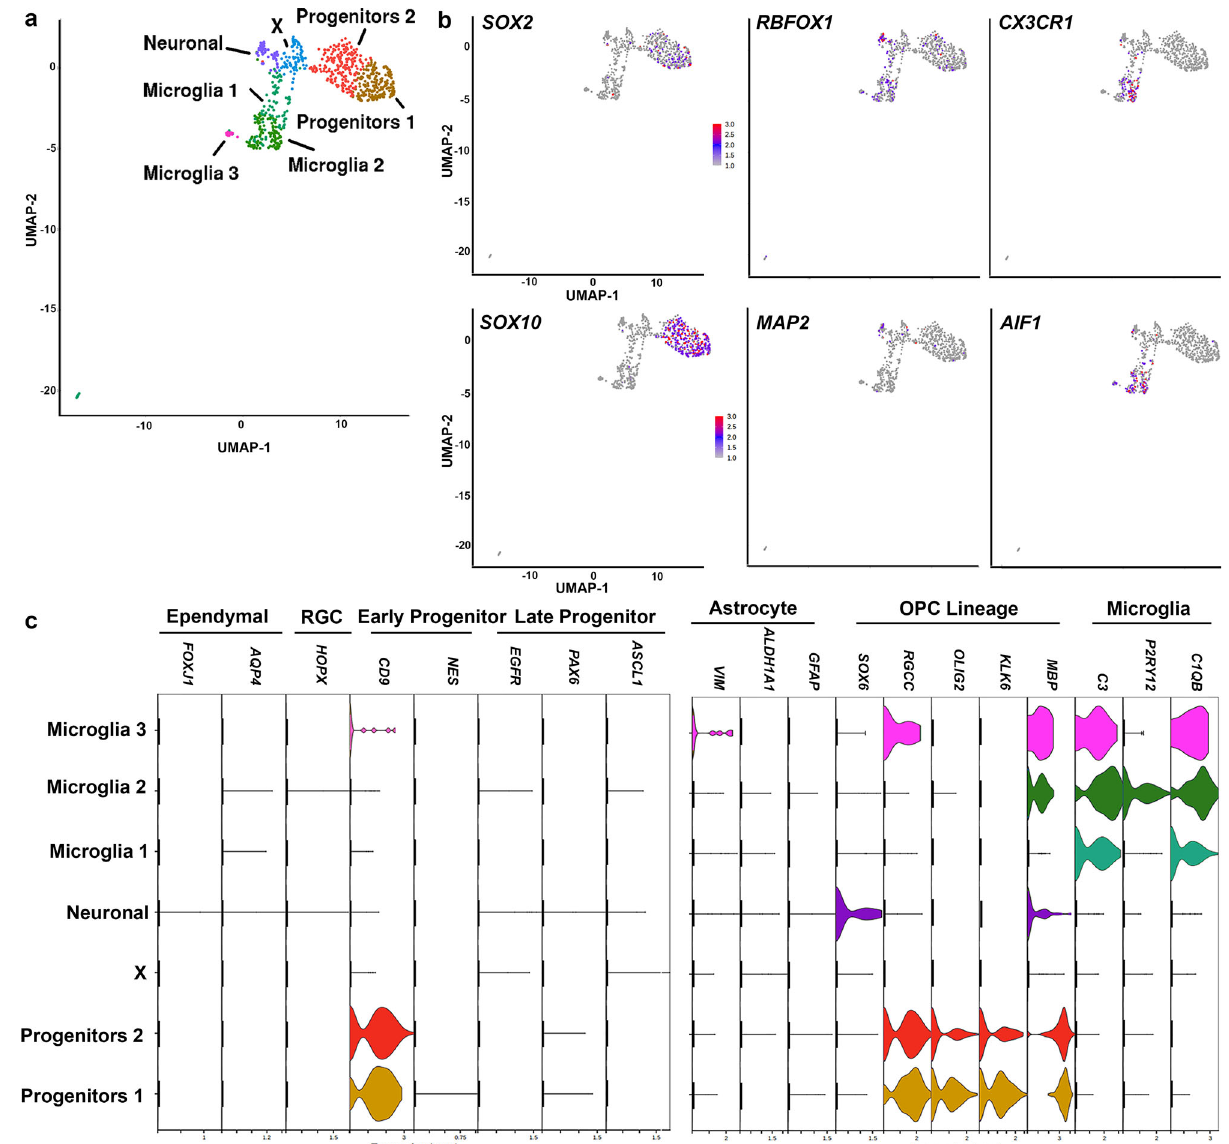
Fig. 1 Characterization of the aged human SVZ at the transcriptome level. a UMAP plot identi fi es seven clusters of cells, corresponding to two progenitor clusters, one neuronal, and three microglia clusters. b Feature plots showing the expression of canonical markers for the clusters: Progenitor 1 and 2 (SOX2; SOX10) , Neuronal ( RBFOX1; MAP2 ), and Microglia 1, 2, and 3 (CX3CR1; AIF1 ). c Feature plots showing the absence or presence of markers for ependymal, radial glial cell (RGC), early progenitor, late progenitor, astrocytes, oligodendrocyte progenitor cell (OPC) lineage and microglia. ( n = 3 donors; 2 females, aged 95 (504 cells) and 96 years (118 cells); 1 male, aged 72 years (116